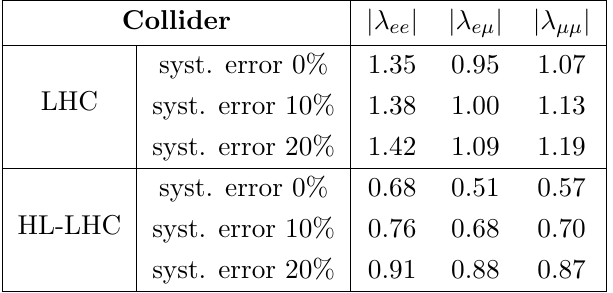
Table 4 . Summary of the 95% C.L. LHC and HL-LHC sensitivities to the couplings j (cid:21) (cid:11)(cid:12) j in our leptonic scalar case with m (cid:30) . 50 GeV [cf. (cid:12)gures 8{10]. Results with 0%, 10% and 20% systematic errors are